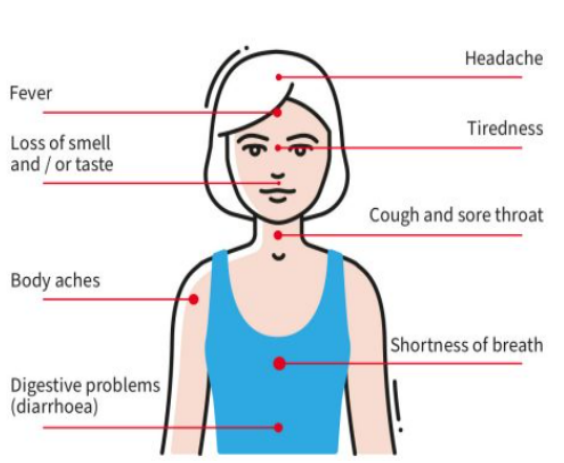
Figure 5. Symptoms of